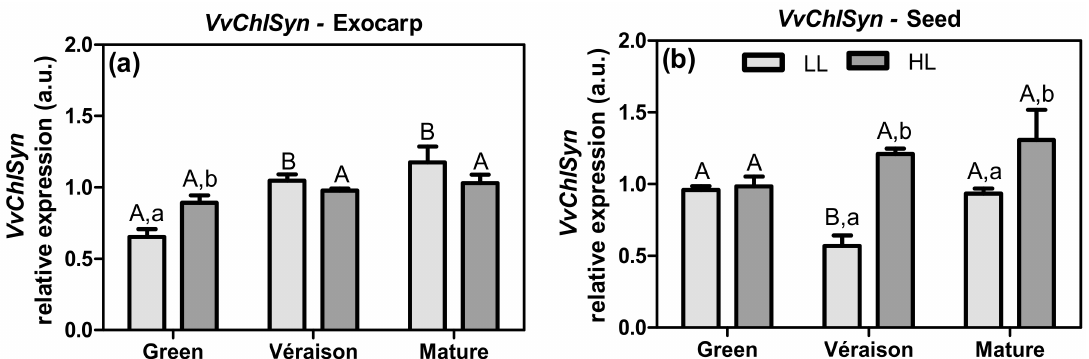
Figure 1. Relative expression in arbitrary units (a.u.) of transcripts of chlorophyll synthase gene ( VvChlSyn ) in ( a ) exocarp and ( b ) seeds, from berries grown at two distinct light microclimates (LL and HL) and at three developmental stages (green, v é raison , and mature), as determined by real-time qPCR. Expression levels are normalized to the mean expression of reference genes VvACT1 and VvGAPDH . Statistical analysis (two-way ANOVA, p ≤ 0.05, n = 3) was applied after data Log(X+1) transformation. Statistical notation: capital letters refer to differences between developmental stages for the same microclimate, and lowercase letters refer to differences between microclimates for each stage. When the letters are omitted, it means that the respective factor did not have a significant